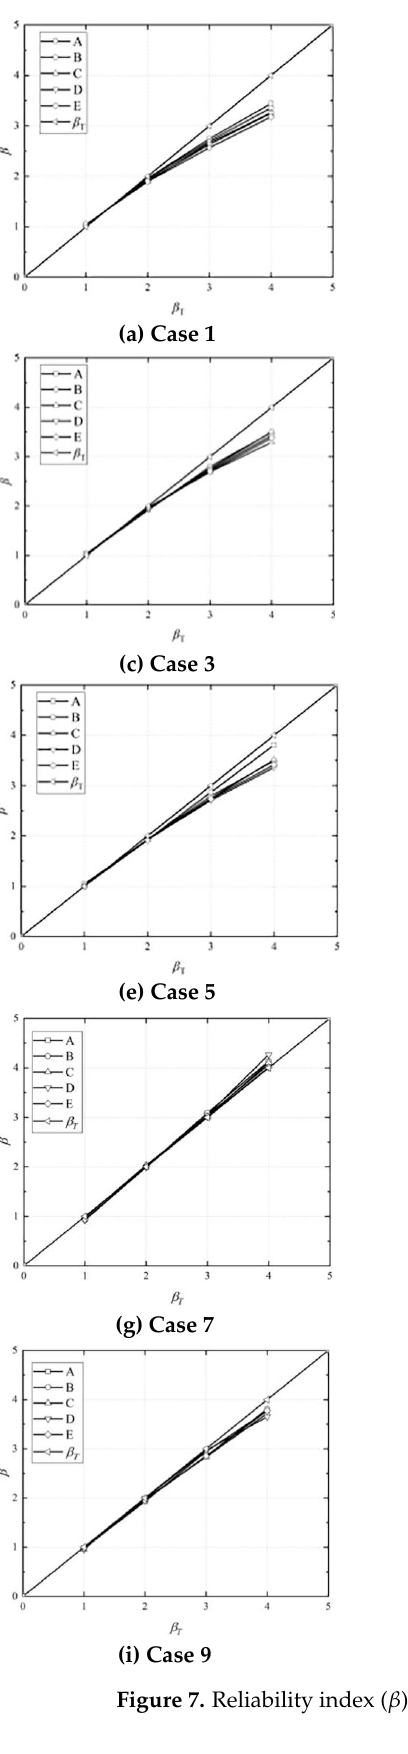
Figure 7. Reliability index (